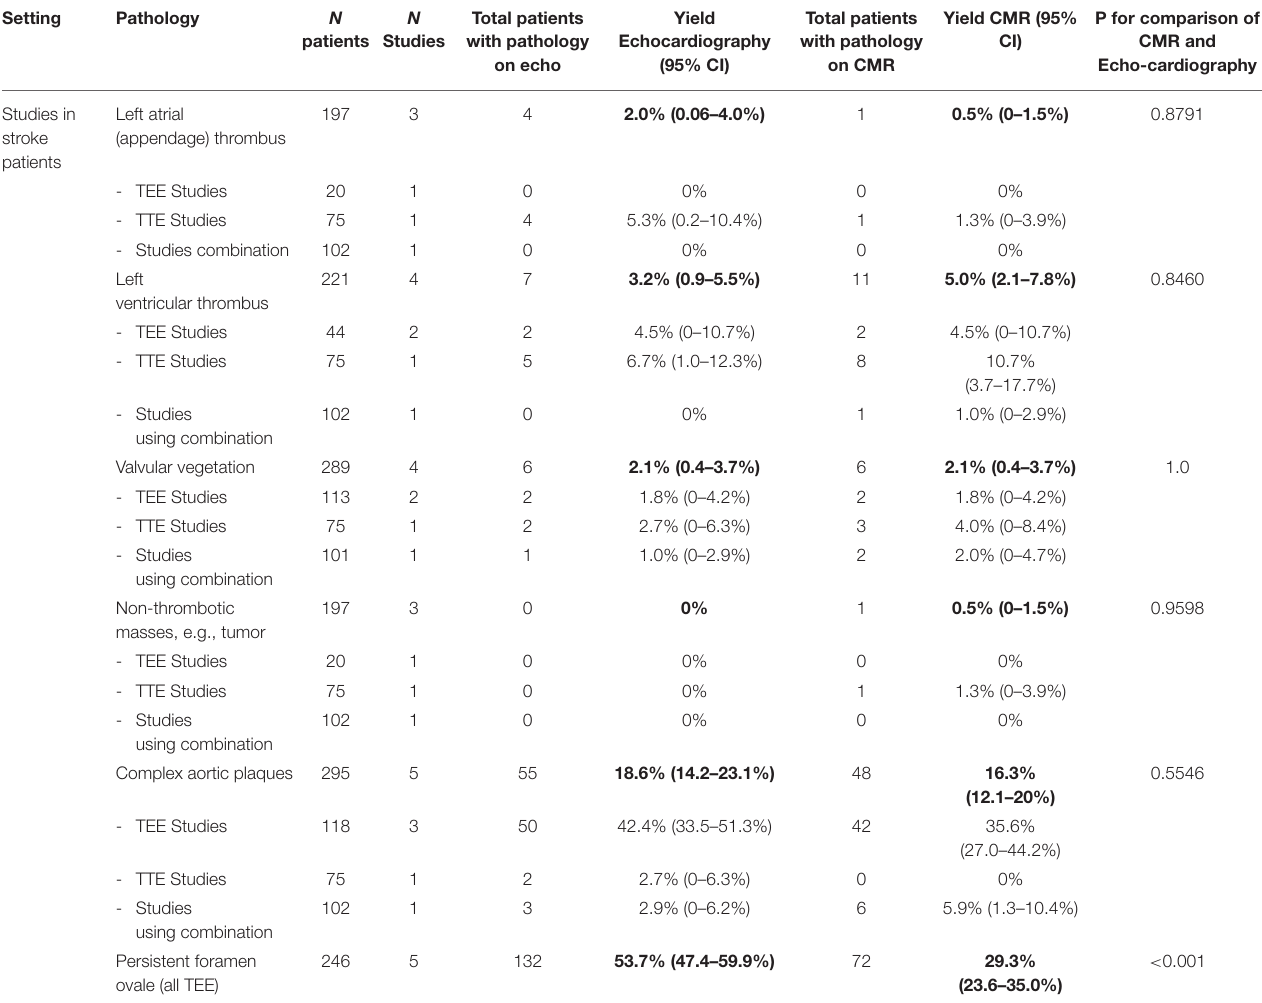
TABLE 3 | Diagnostic yield of cardiovascular MRI as compared to echocardiography for detection of prespecified cardioaortic sources of embolism in studies including patients with stroke.